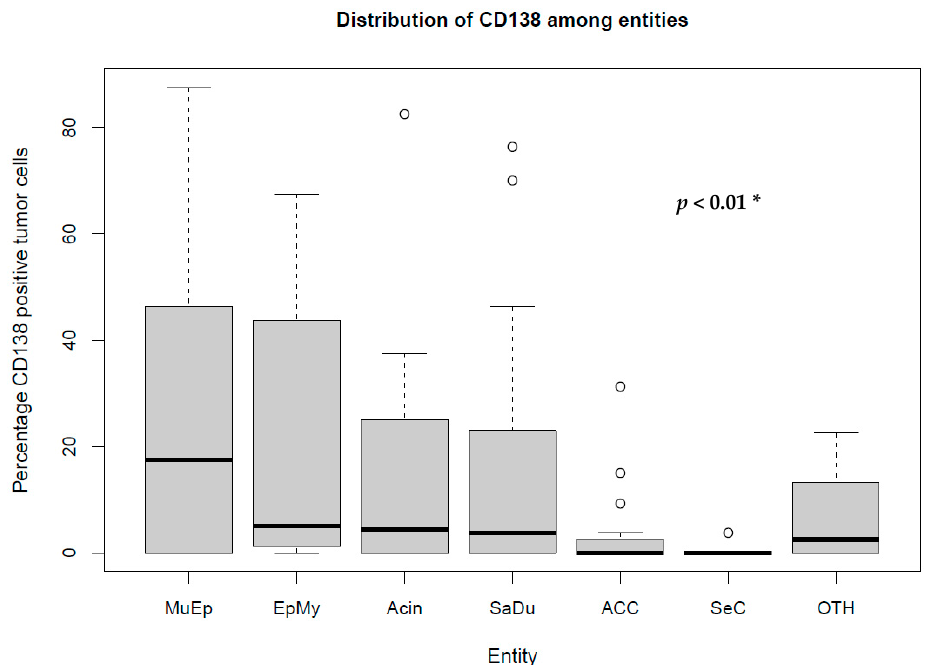
Figure 2. Box plot displaying the distribution of the percentages of CD138-expressing tumor cells among the most frequent entities. MuEp = Mucoepidermoid carcinoma, EpMy = Epithelial-myoepithelial carcinoma, Acin = Acinic cell carcinoma, SaDu = Salivary duct carcinoma, ACC = Adenoid cystic carcinoma, SeC = Secretory carcinoma, OTH = Others. * Kruskal–Wallis test. ◦ Outliers.